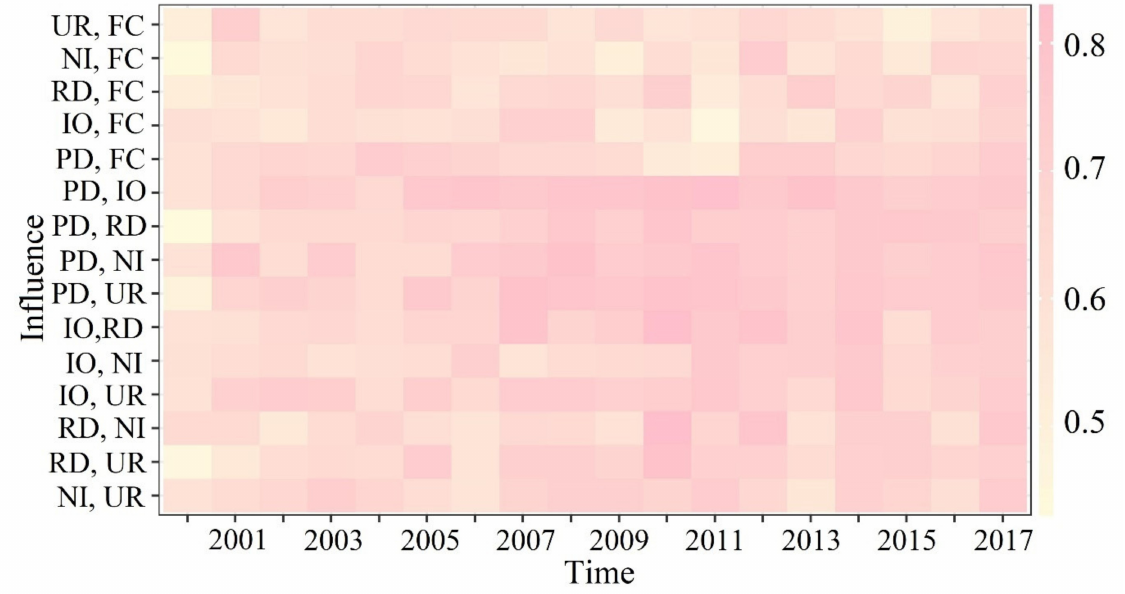
Figure 7. Heatmap of interactive effects from